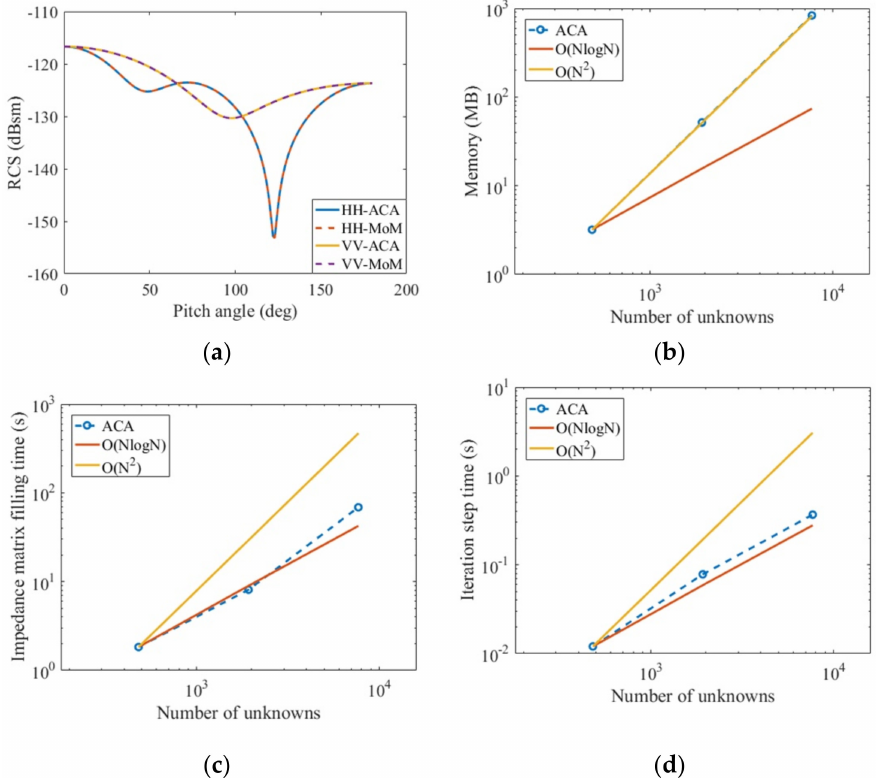
Figure 9. Related analysis of a gold nanosphere calculated by MoM and ACA: radius 200 nm, incident wavelength 550 nm, ε 1r = − 8.0 – j 1.66, µ 1r = 1.0. ( a ) Bistatic RCS; ( b ) memory occupied by the near field matrix; ( c ) filling time of impedance matrix; ( d ) average solution time per